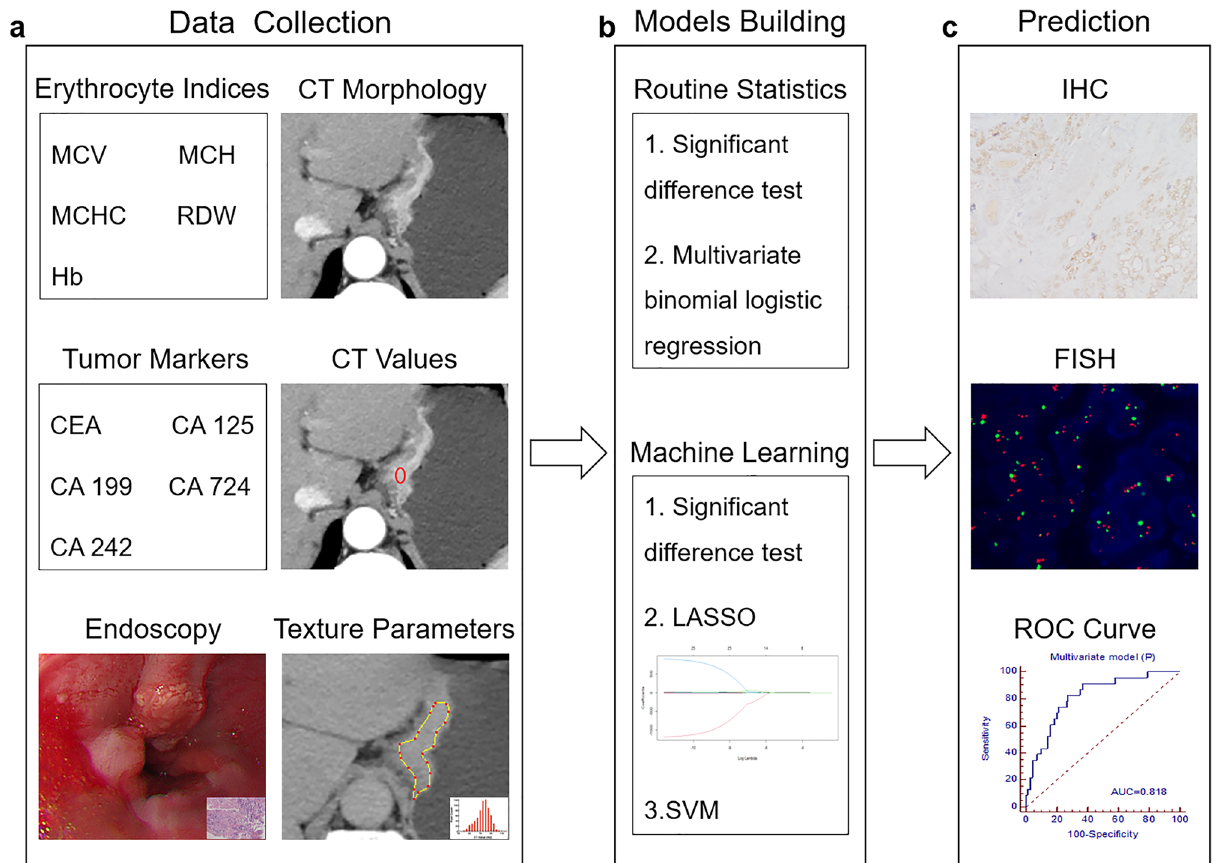
Figure 2. The workflow of this study. ( a ) Erythrocyte indices, tumor markers, differentiation degree based on biopsy, CT morphological characteristics, CT value-related and texture parameters were extracted. ( b ) Multivariate models were built based on binomial logistic regression and machine learning algorithm. ( c ) The overexpression of human epidermal growth factor receptor 2 (HER2) in gastric cancer was tested by IHC based on surgical specimens, samples scored as IHC 2 + (equivocal) were additionally detected by FISH. Diagnostic performance for predicting HER2 status was obtained by ROC curve analysis. MCV mean corpuscular volume, MCH mean corpuscular hemoglobin, MCHC mean corpuscular hemoglobin concentration, RDW red cell distribution width, Hb hemoglobin, CEA carcinoembryonic antigen, CA carbohydrate antigen, CT computed tomography, LASSO least absolute shrinkage and selection operator, SVM support vector machine, IHC immunohistochemistry, FISH fluorescence in situ hybridization, ROC receiver operating